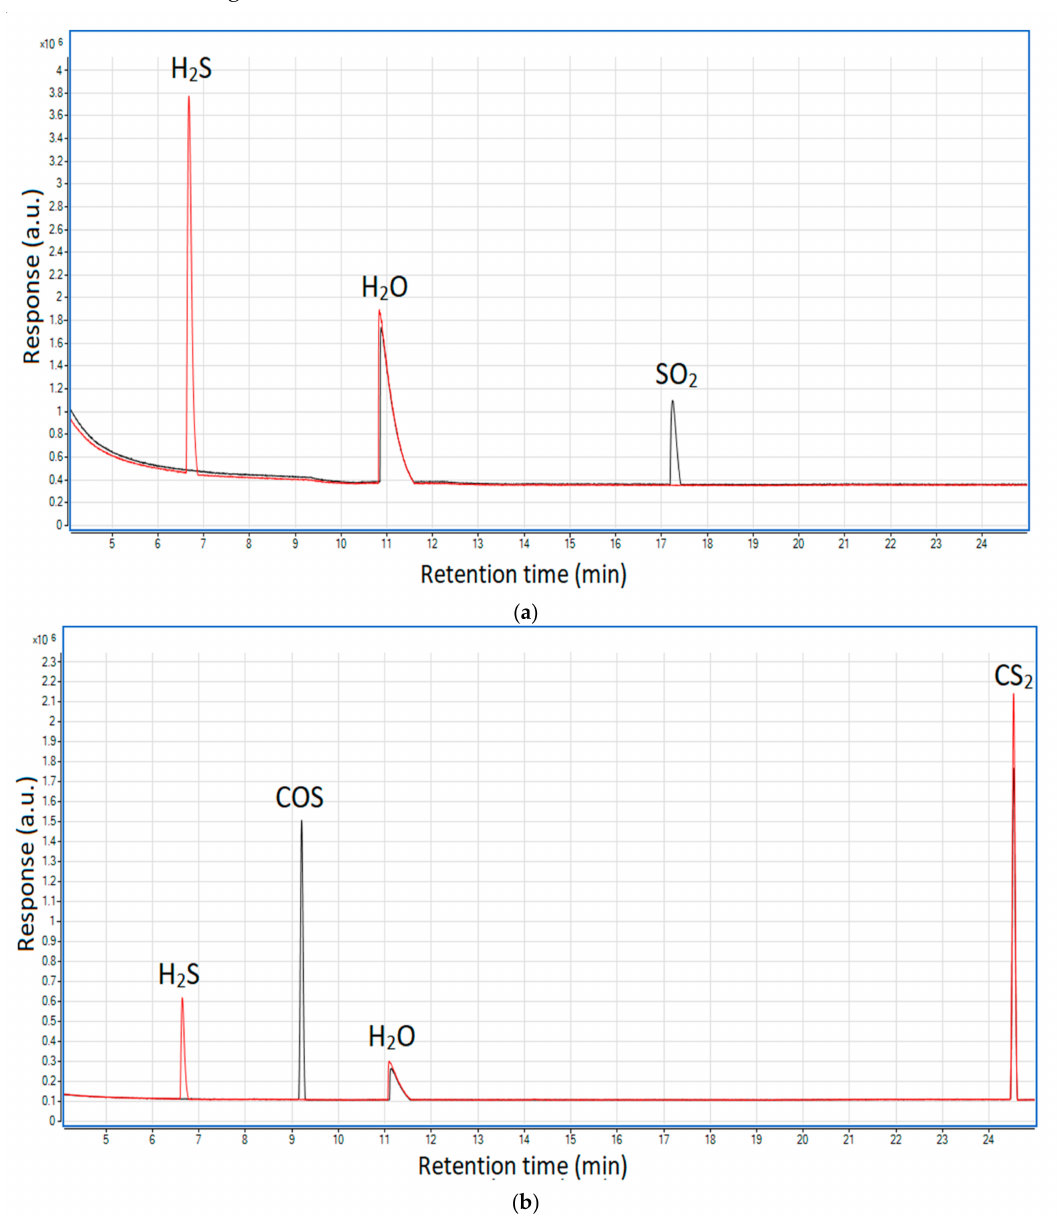
Figure 8. Chromatograms showing the influence of hydrogen on hydrogen sulfide formation: ( a ) from sulfur dioxide and ( b ) from carbonyl sulfide and carbon disulfide. Black line—before the plasma reactor; red line—after the plasma